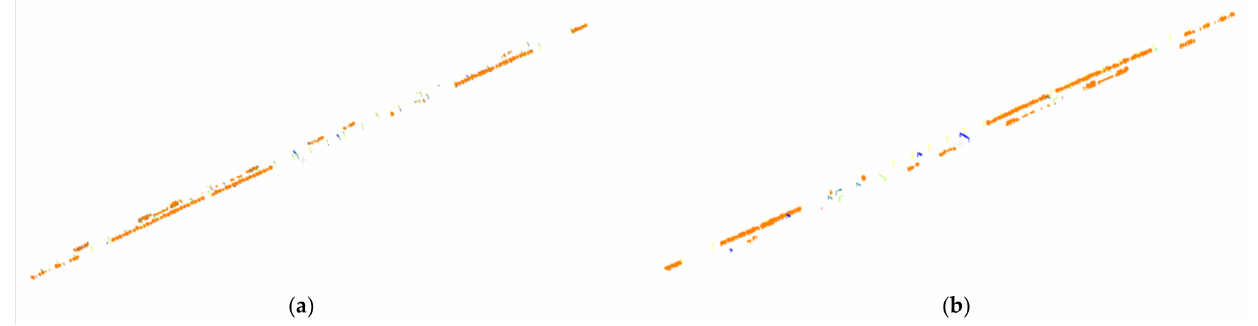
Figure 14. Classified results. Figure ( a ) represents the classified results based on the local features, and Figure ( b ) represents the classified results based on the global features.